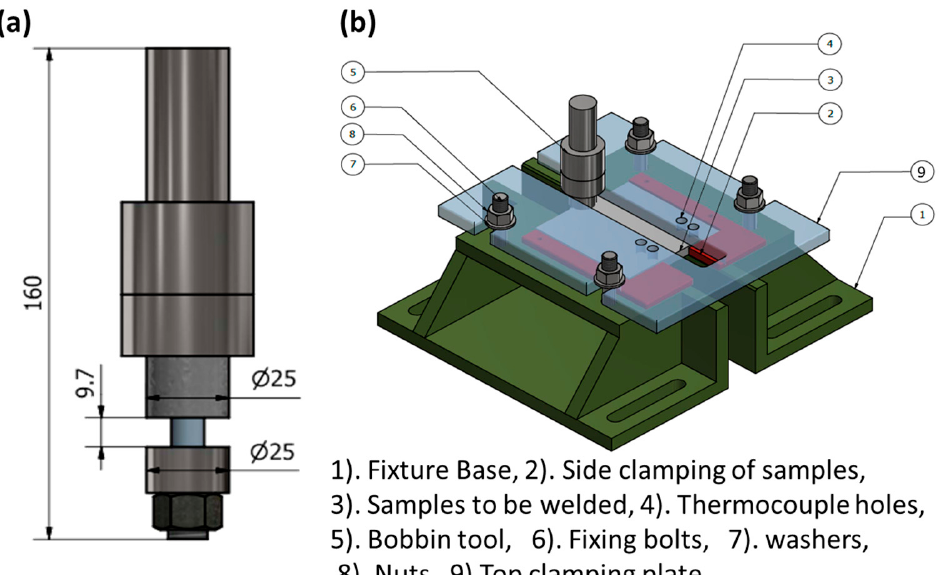
Figure 16. Schematic for ( a ) the FSW bobbin tool for welding 10 mm-thick aluminum, and ( b ) an example of the fixture setup for BTFSW.